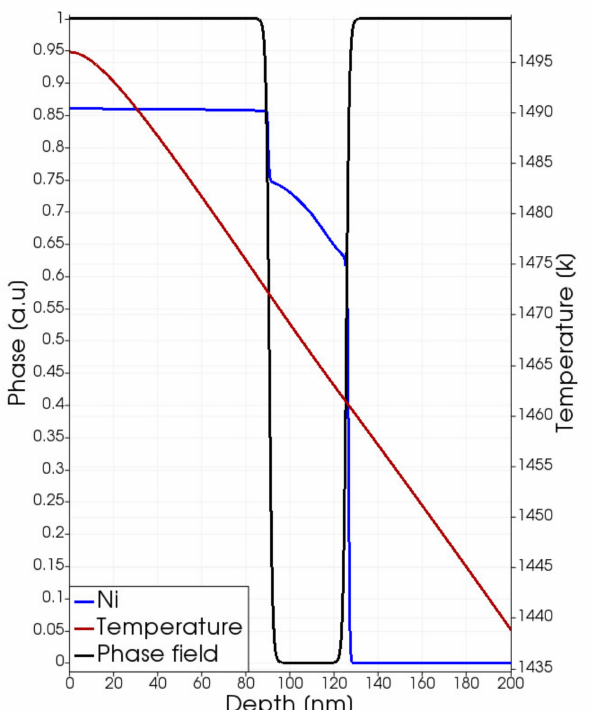
Figure 4. Phase-field (black line), temperature (dark red line) and Ni total atomic fraction (blue line) as a function of the position after 220 ns of the simulated irradiation at E dens = 2.5 J/cm 2 energy density. We note the phase and atomic fraction have the same range of